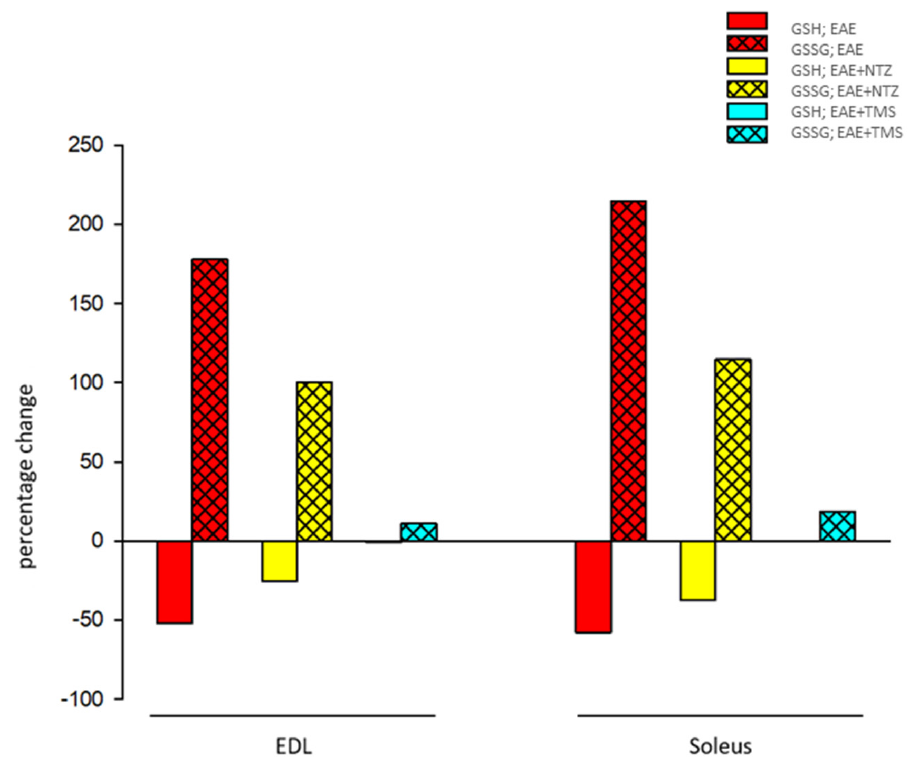
Figure 2. Percentage variations of mean values in the oxidative enzymatic activity parameters for the extensor digitorum longus (EDL) and soleus muscles in the different groups in relation to mean values in control groups.